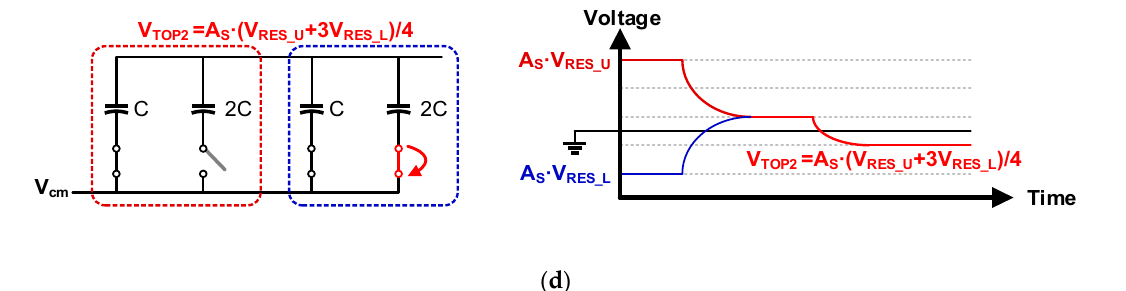
Figure 10. Conceptual operations from SAR ADC: ( a ) VRES_U sampling on CDACU; ( b ) V RES_L sampling on CDAC L ; ( c ) MSB 2nd conversion; ( d ) MSB 2nd-1 conversion.